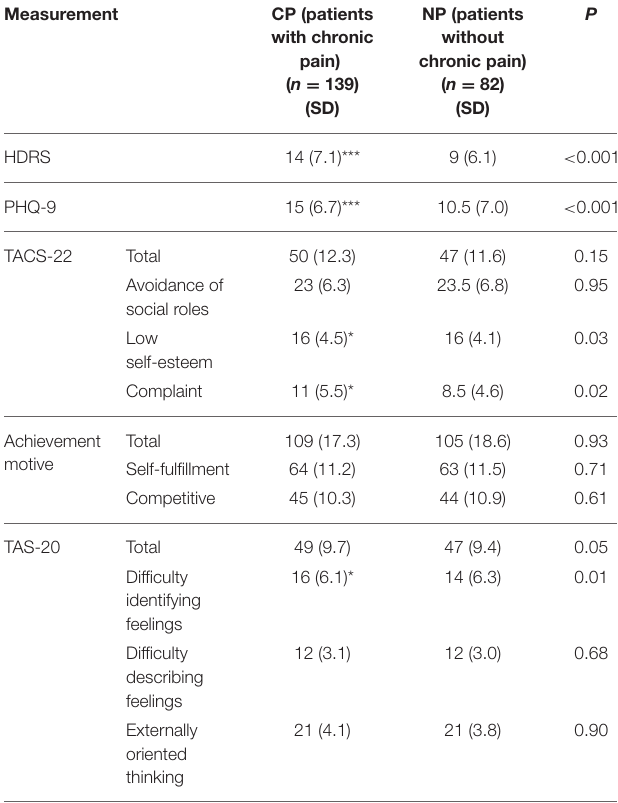
TABLE 2A | Comparison of medians ( n = 221). Measurement